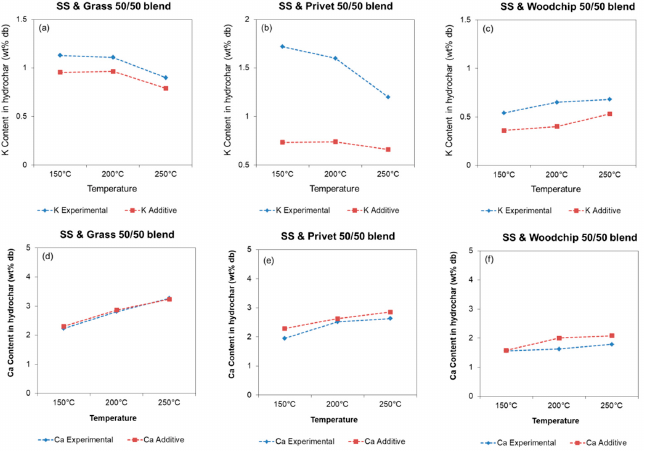
Figure 8. Comparison of experimental and additive levels in the hydrochar of ( a ) K content for SS and grass at 50/50 blend, ( b ) K content for SS and privet hedge at 50/50 blend, ( c ) K content for SS and woodchip at 50/50 blend, ( d ) Ca content for SS and grass 50/50 blend, ( e ) Ca content for SS and privet hedge for 50/50 blend, and ( f ) Ca content for SS and woodchip for 50/50 blend.